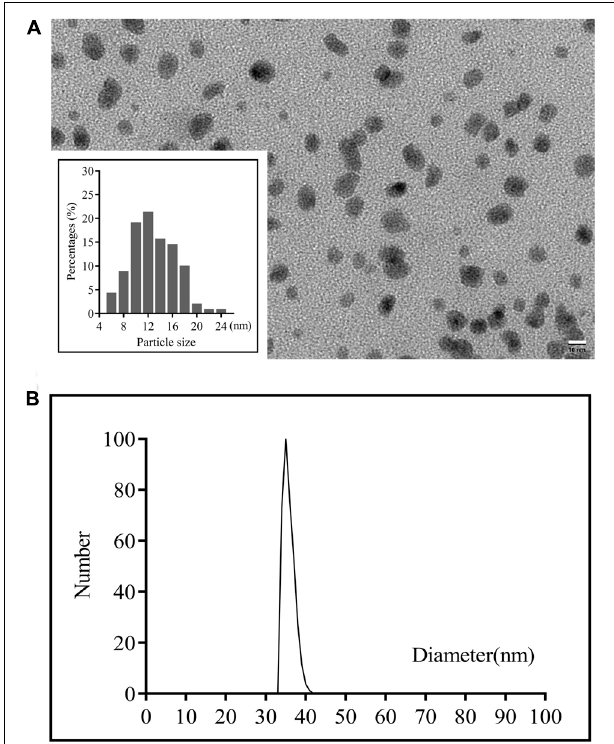
FIGURE 2 | (A) TEM images of the CuS NPs (scale bar 50 nm) and (B) Particle sizes of the CuS NPs detected by DLS.